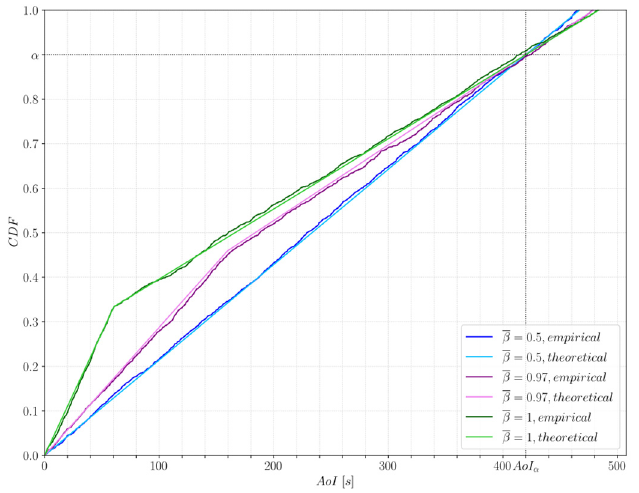
Figure 11. Theoretical AoI CDF and empirical AoI CDF for 𝜆 = 1 (cid:3403) 180 s (cid:2879)(cid:2869) , 𝛼 = 0.9 , 𝐴𝑜𝐼 (cid:3080) = 420 s .